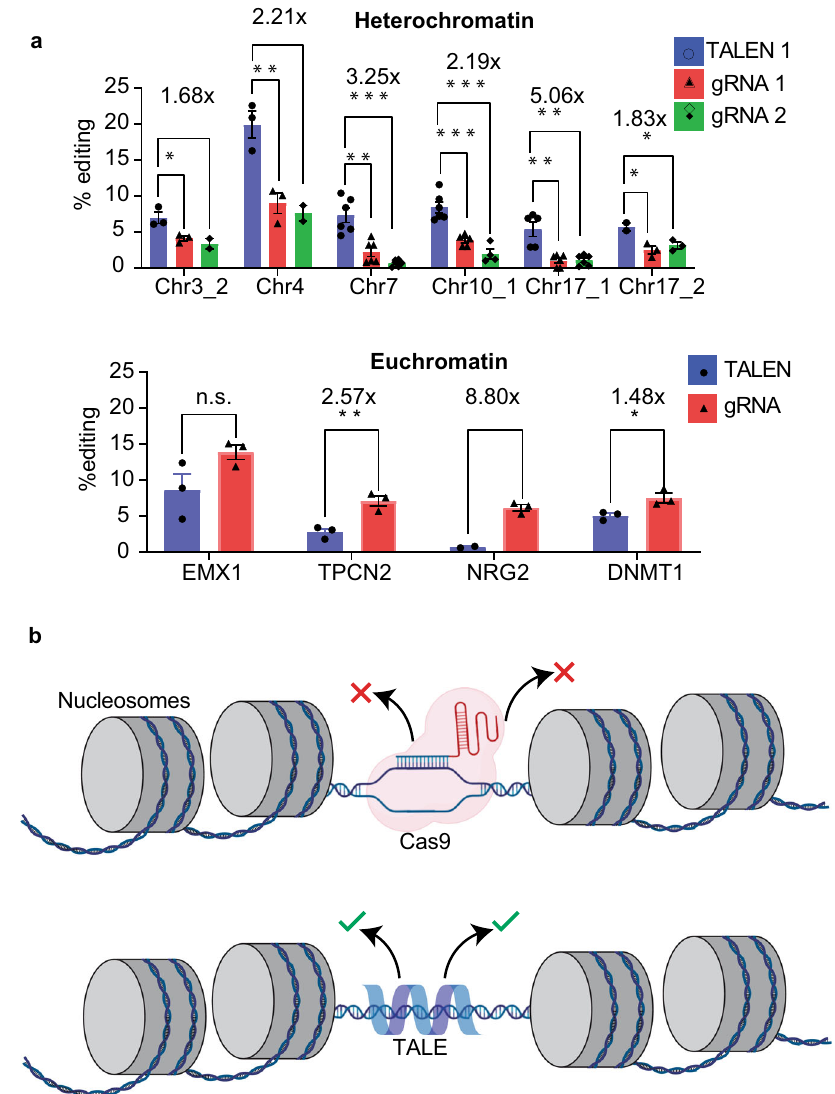
Fig. 5 Systematic comparison of TALE and Cas9 editing ef fi ciency in heterochromatin. a TIDE analysis of variants of Cas9 and TALEN that target different heterochromatin and euchromatin loci. 50% of the heterochromatin loci are modi fi ed more ef fi ciently by TALENs than Cas9 (top). Cas9 has a higher editing ef fi ciency than TALE in the euchromatin regions (bottom). TALENs with the highest predicted cutting ef fi ciency were designed using CHOPCHOP and SAPTA. gRNAs with the highest predicted cutting ef fi ciency were designed using Benchling and CHOPCHOP. TALEN samples are compared to Cas9-gRNA samples by a 2-tailed t test for n > 2. n = {2,3,4,5,6} biological replicates. Data are presented as mean values ± SEM. p < 0.05*, p < 0.01**, p < 0.001***. p -values are given in brackets: Chr3_2 (0.2755, 0.05), Chr4 (0.0096, 0.0171), Chr7 (0.0014, 6.02e-5), Chr10_1 (0.00069, 0.00033), Chr17_1 (0.00179,0.00169), Chr17_2 (0.0027,0.0326), EMX1 (0.0999), TPCN2 (0.0077), NRG2 (0.0025), DNMT1 (0.0274). Source data